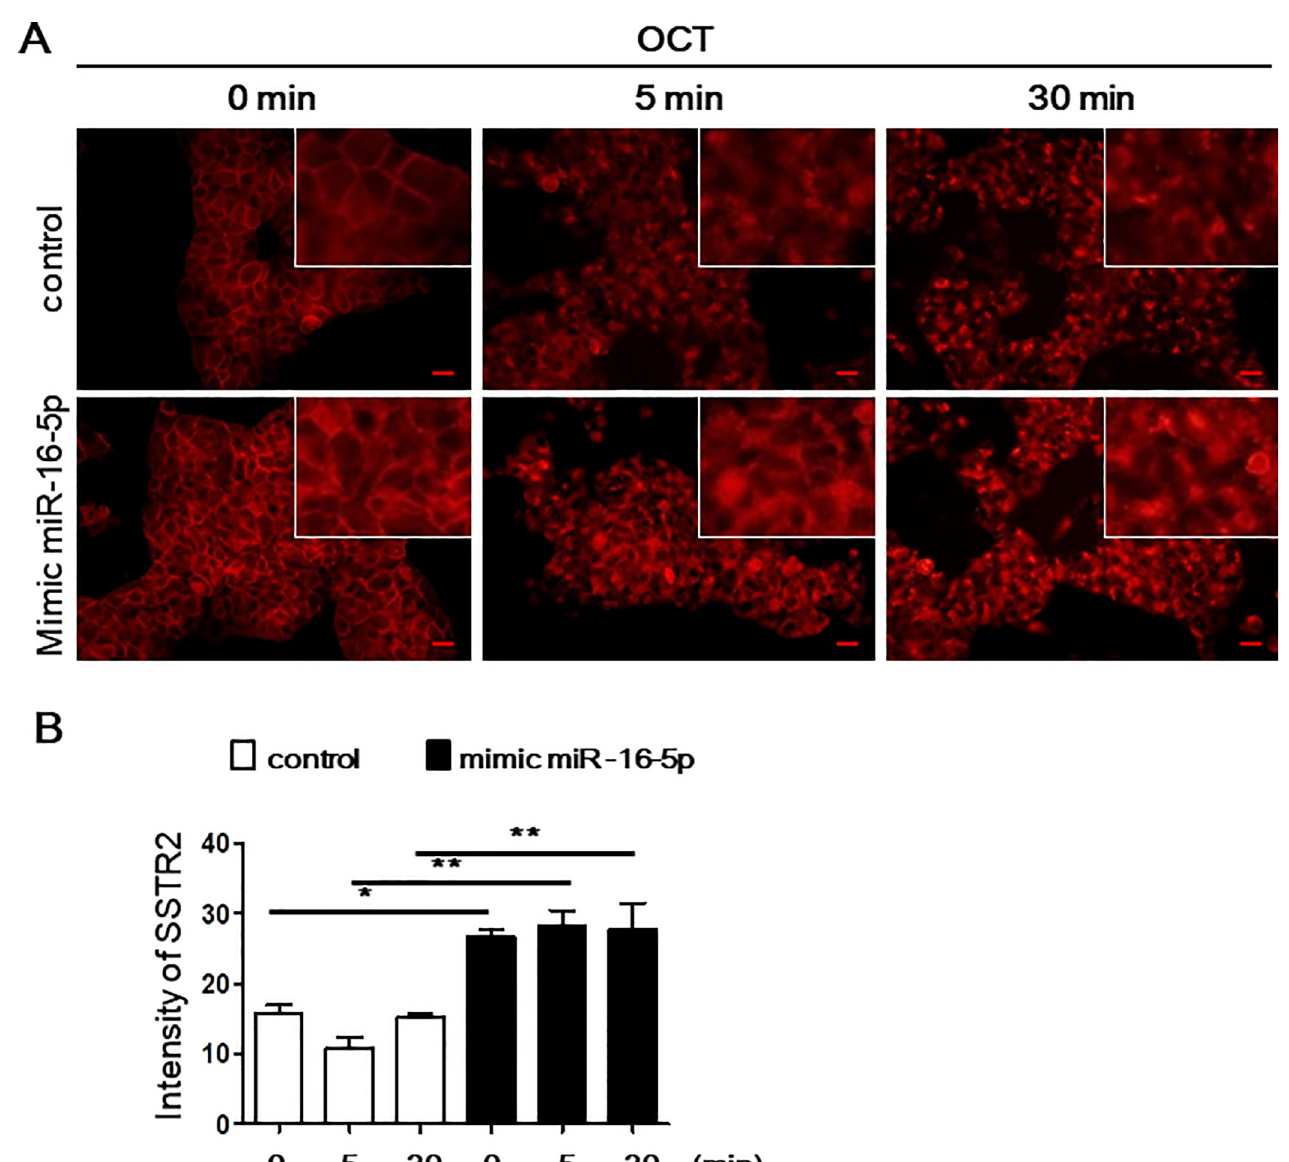
Fig 4. Upregulation of SSTR2 expression in INS-1 cells after octreotide treatment with mimic miR-16-5p. (A) INS-1 cells were transfected with 100 pmol of mimic miR-16-5p or control miRNA for 24 h and then treated with 1 μ mol/L octreotide for the indicated durations. The cells were then fixed and processed for immunofluorescence staining of SSTR2 protein. Scale bar: 20 μ m. (B) Fluorescence intensity of SSTR2 was measured with IMT i-Solution Industrial Image Analysis